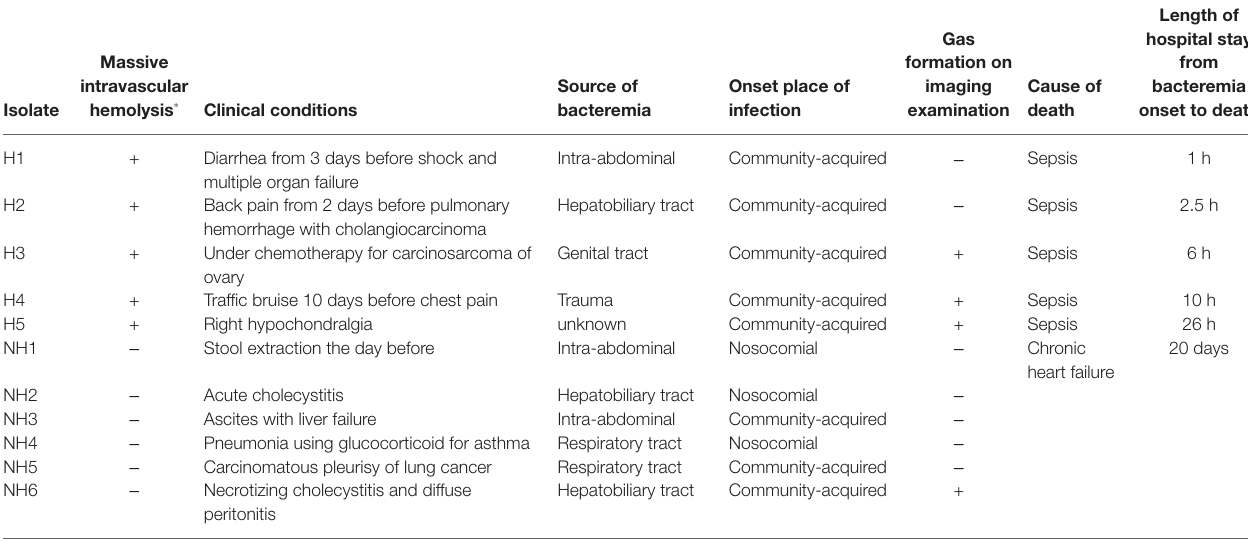
TABLE 1 | Clinical profiles of 11 blood-derived Clostridium perfringens isolates used in this study.